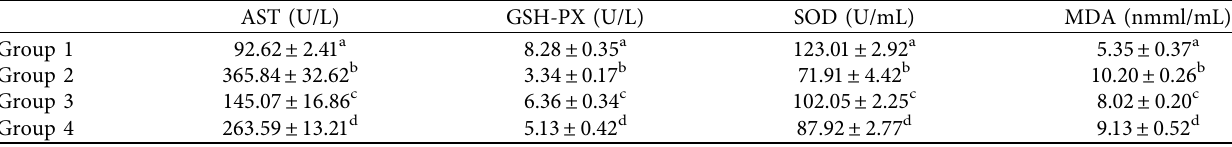
Table 1: Effects of SDF on AST, GSH-PX, and SOD activities and MDA content in nondiabetic and diabetic mouses.